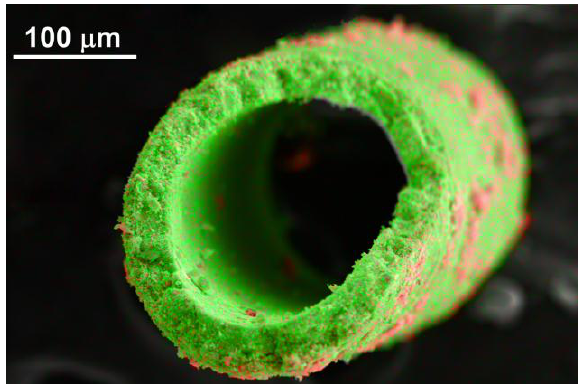
Figure 7. Secondary electrons image and EDX map of the Ni-rich microtube obtained after detachment of the external Cu-rich microtube.